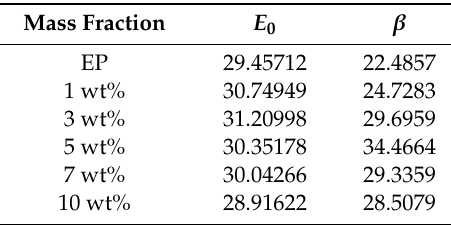
Figure 8. Weibulldistribution of the breakdown strengths of Al 2 O 3 -NWs / epoxy resin composites with di ff erent mass ratios. Weibull distributions of scale and shape parameters of the pure epoxy resin and Al 2 O 3 -NWs / epoxy resin composites with di ff erent mass